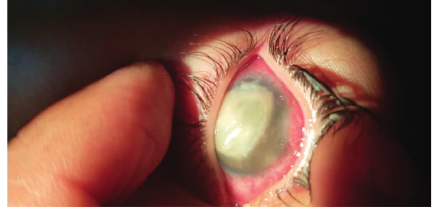
Figure 4: Intense corneal infiltrate and AC